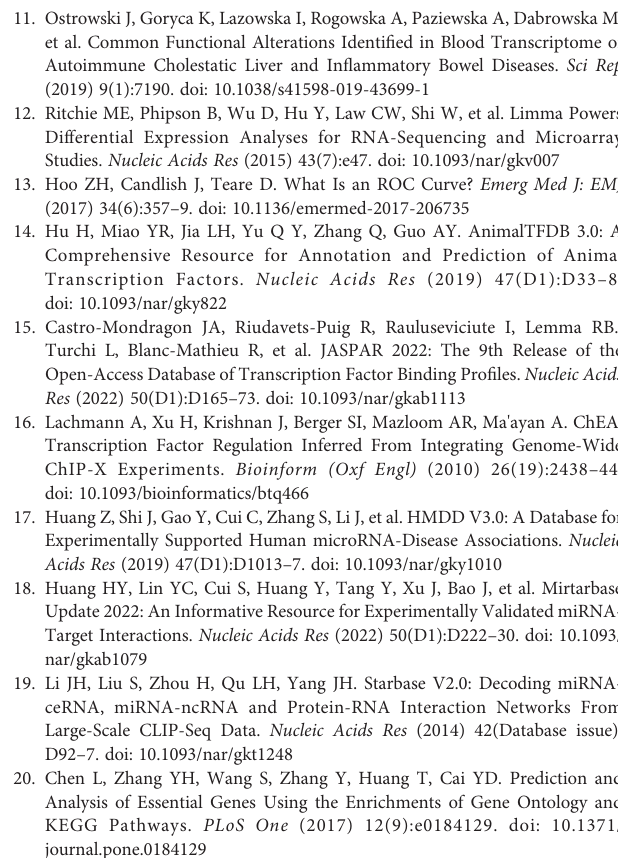
Supplementary Figure 1 | The KEGG pathway of Th17 cell differentiation. Supplementary Figure2 | TheKEGG pathwayof